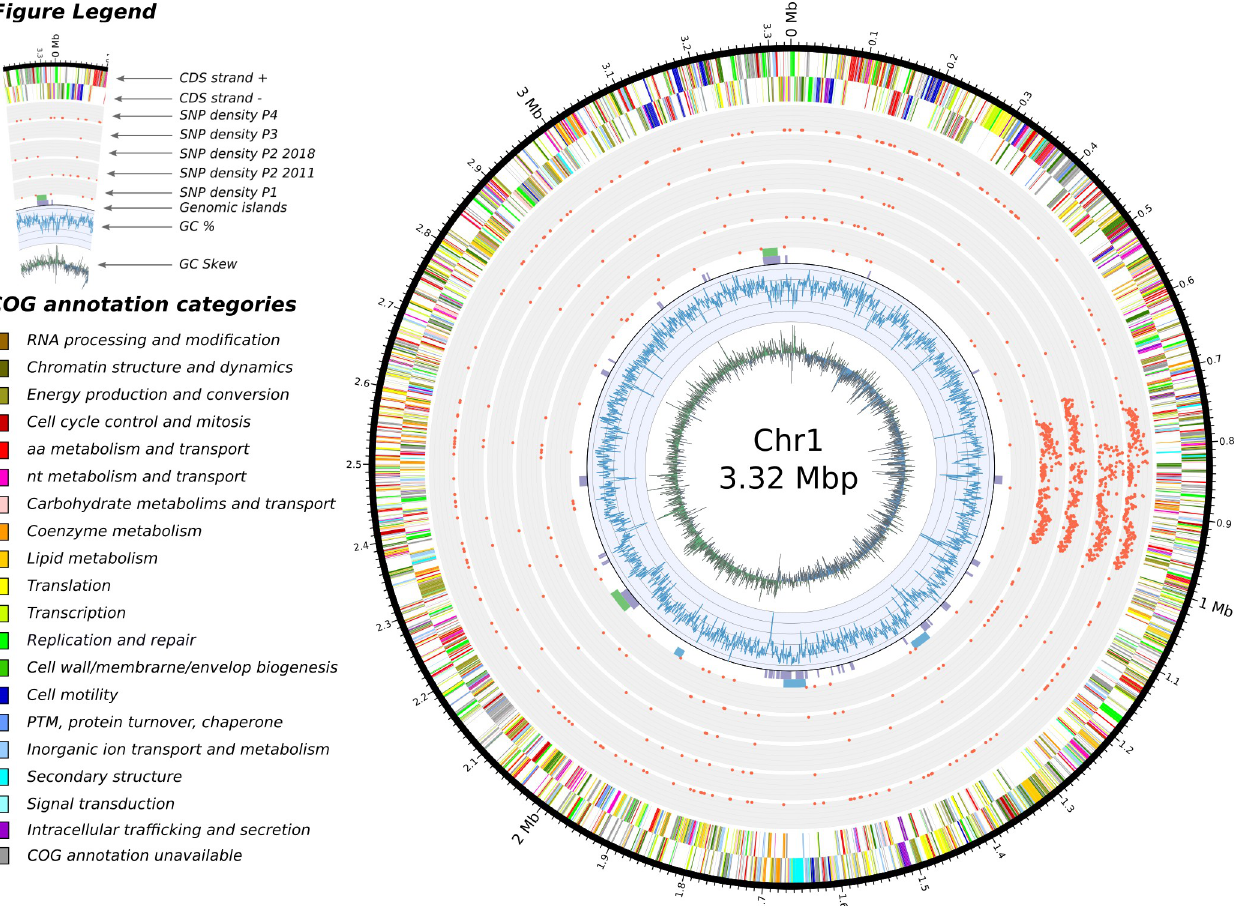
Fig 5. Features of chromosome 1 and SNP densities comparisons. In concentric circles, from the center and outward are depicted: 1) the GC skew, 2) the GC content, 3) the genomic islands detected by the software IslandViewer 4 (in purple), the prophages detected with Phaster (green) and the secondary metabolites identified by antiSMASH (in blue), 4) a total of five SNP densities, we separated the isolates from 2011 and the isolate from 2018 in patient 2 as we regard them as two separate acquisition events, 5) and 6) the annotated features found on the negative and positive strand respectively.